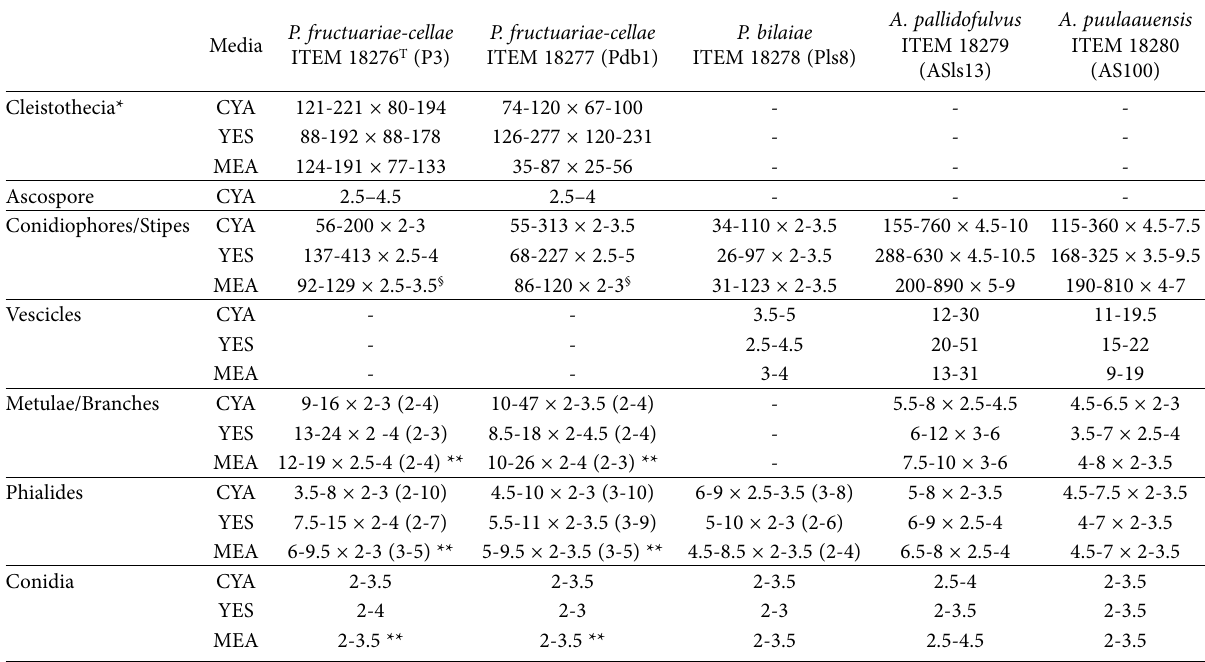
Table 3. Micromorphological characteristics of Penicillium and Aspergillus isolates after 7 d growth on different agar media. All dimensions are in μm. Numbers of metulae or phialides are indicated in